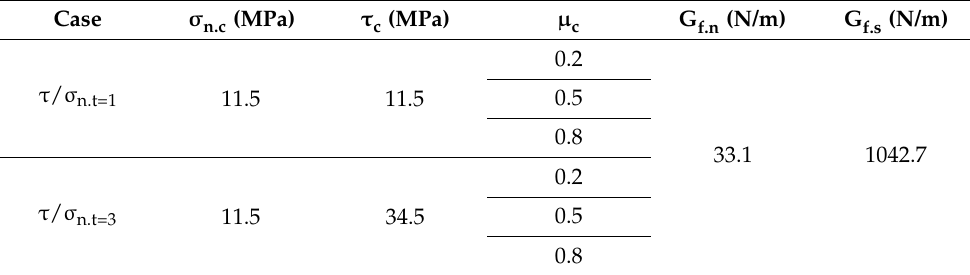
Table 6. Strength properties for the particle models: Influence of contact friction. Case